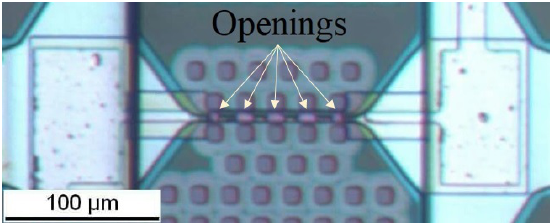
Figure 4. Top view of the fabricated composite heater with 5 openings. The three openings at the center have a length of 10 µ m and a width of 6 µ m, while the two openings at the extremities have a length and width of 6 µ